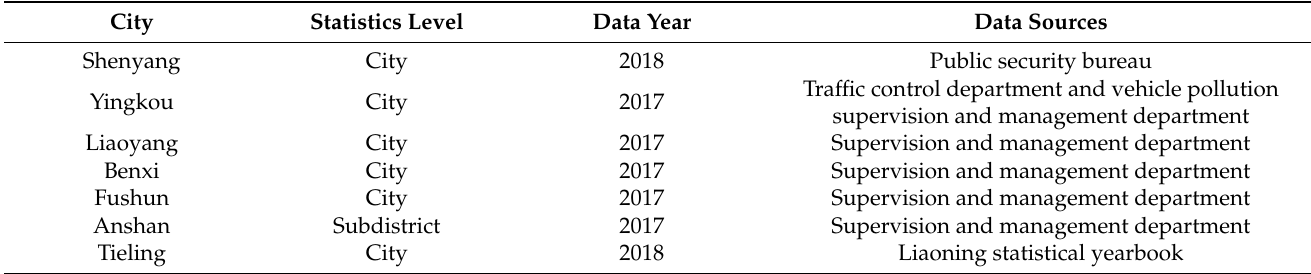
Table 1. Data sources used to obtain the parameters required for the CLUA vehicle inventory.